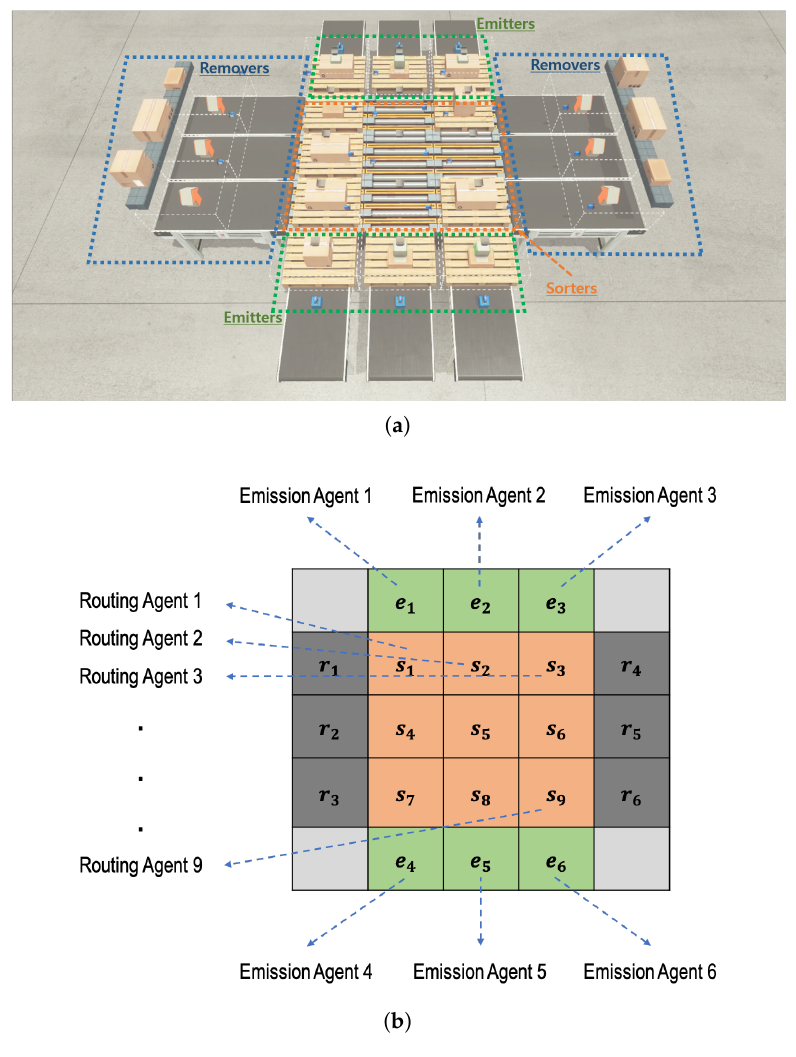
Figure 1. A three-gird instance of the proposed n -grid sortation system. ( a ) Main components of the three-grid sortation system; ( b ) Raw state representation of the three-grid sortation